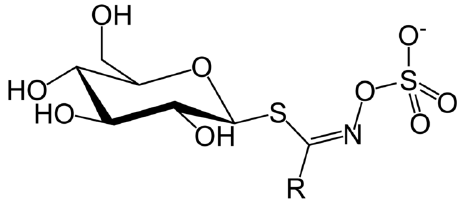
Figure 2. Glucosinolate general structure.